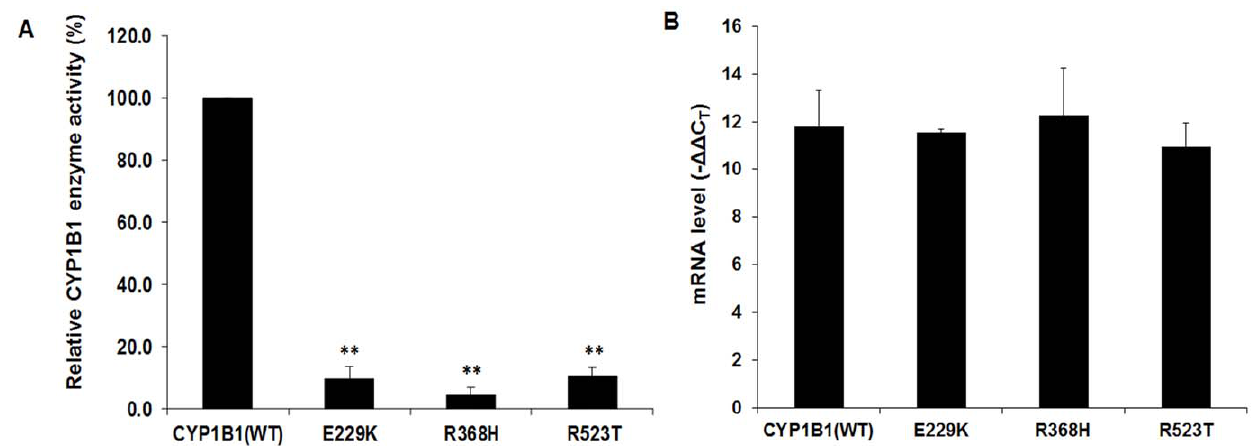
Figure 7. CYP1B1 mutants have lower 17 b estradiol metabolizing activity compared to wild type protein. A : The enzyme activity of the mutant proteins was expressed as percentage of the activity retained as compared to the native (wild type) enzyme. Mutant constructs of CYP1B1 (i.e. E229K, R368H and R523T) showed , 10% of 17 b estradiol metabolizing activity (**p-value , 0.001). B : Histogram showing the expression level of the transfected wild type and mutant constructs of CYP1B1 in RPE cells as detected by RT-PCR. Three independent replicates were performed for this experiment.